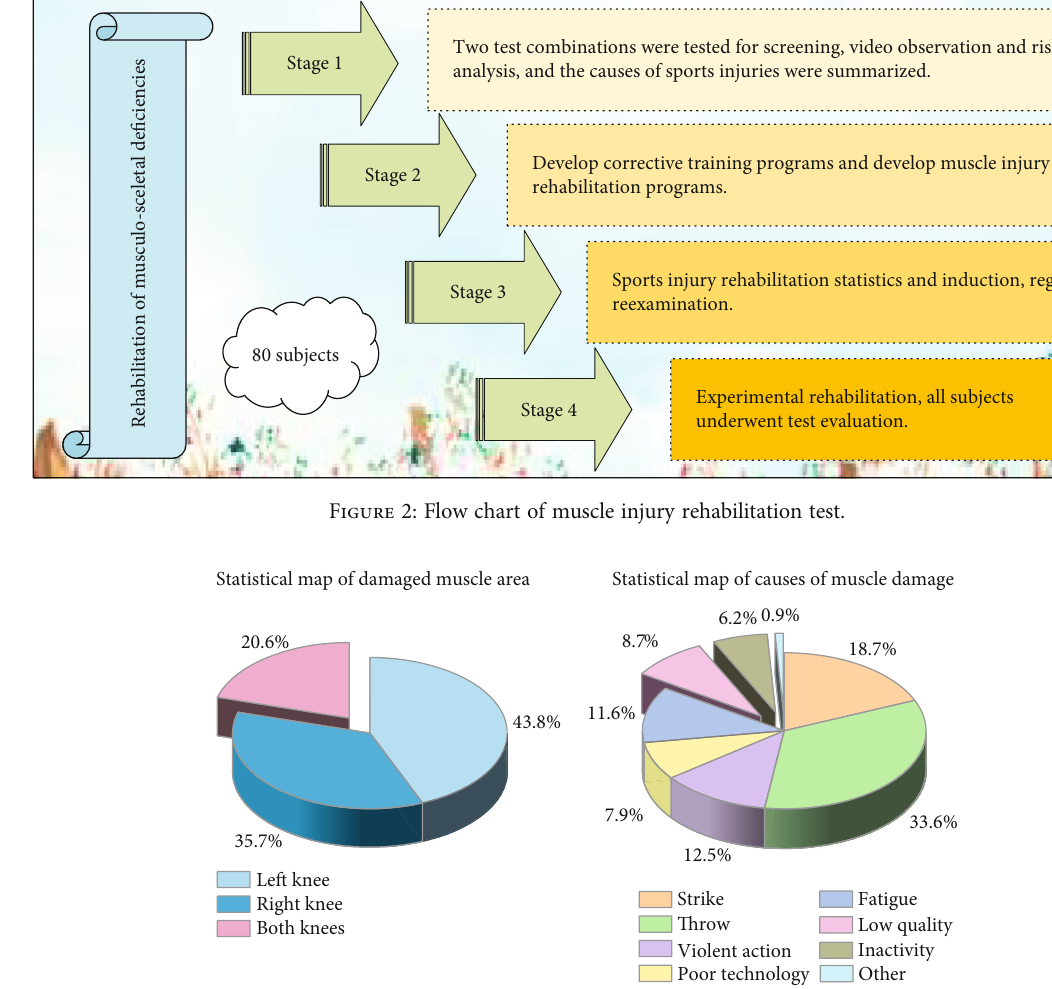
Figure 3: The cause and location of health